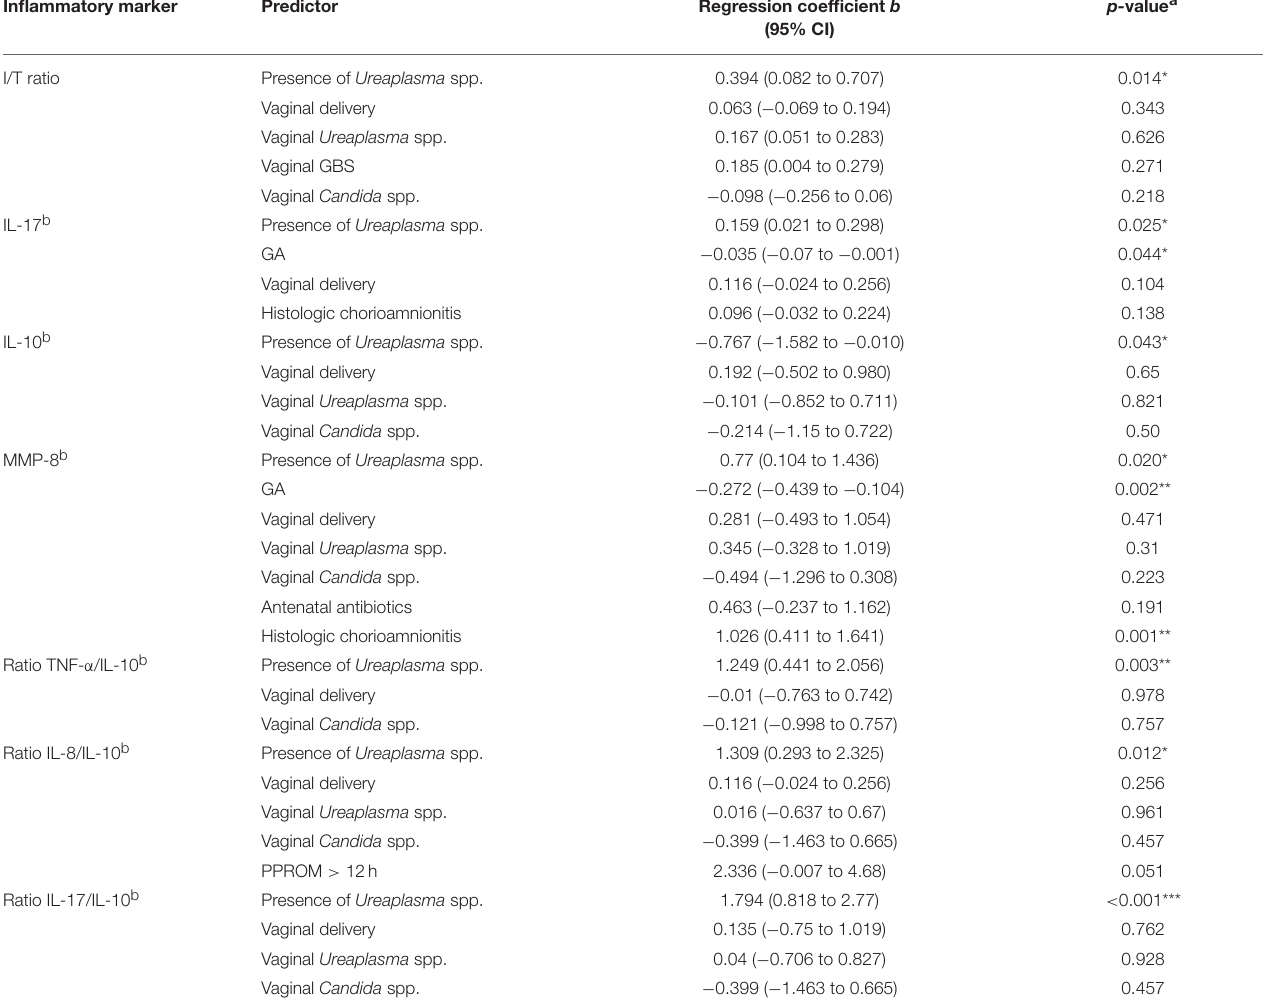
TABLE 4 | Inflammatory markers associated with positive Ureaplasma screening adjusted for confounding variables. Inflammatory marker